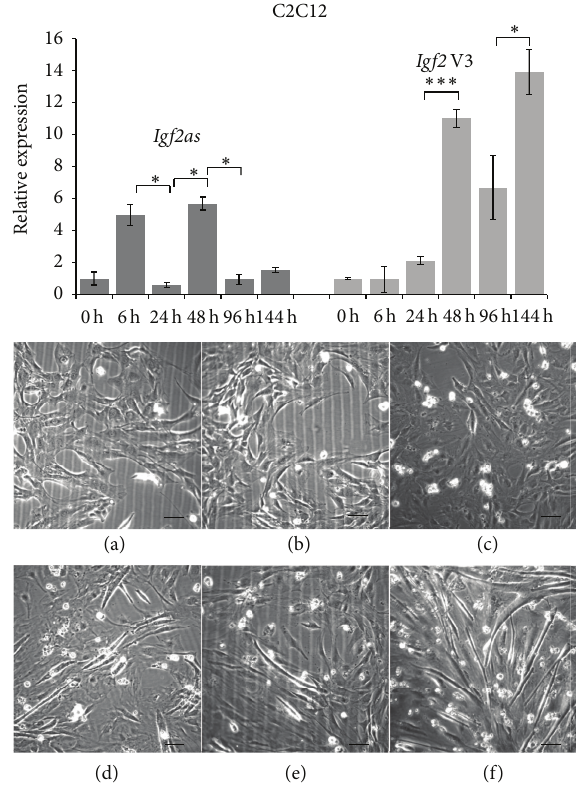
Figure 3: Quantification of Igf2 and Igf2as expression during C2C12 myoblast differentiation. The C2C12 cells were maintained in differentiation media (DM) during a total time of 144 h. In the graph V3 and Igf2as correspond to Igf2 variant 3 and Igf2as transcripts, respectively. The results are presented in relative expression. Each bar represents the mean of cells from three culture flasks each quantified in triplicate. The standard deviation for each time point is indicated. The images of C2C12 murine myoblast cells correspond to (a) C2C12 in growth media, (b) C2C12 after 6h, (c) 24 h, (d) 48 h, (e) 96h, and (f) 144 h in DM. The scale bar is indicated (30 𝜇 m). ∗ 𝑃 < 0.05 and ∗∗∗ 𝑃 < 0.001